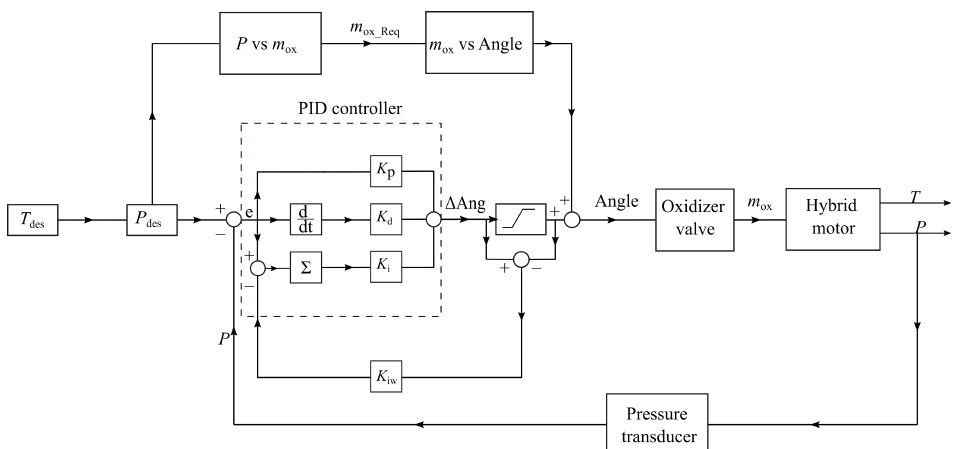
Figure 7. Block diagram of the controller.